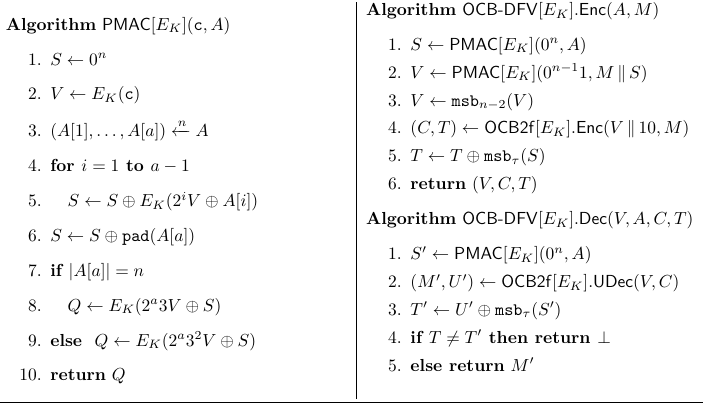
Figure 8: OCB-DFV , a birthday-secure, block cipher-based DFV . OCB2f is from [IIMP19] and shown in Figure 10 (Appendix